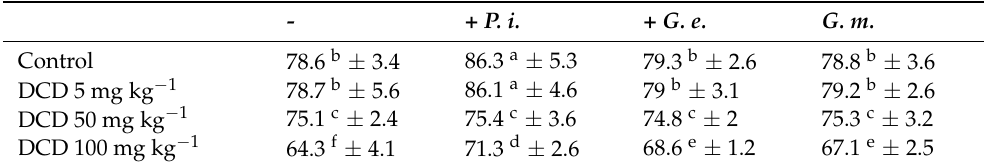
Table 2. Effect of Piriformospora indica, Glomus mosseae , and Glomus etunicatum on the stomata pore area ( µ m 2 ) under different concentrations of DCD in lettuce. - + P. i. + G. e. G. m.